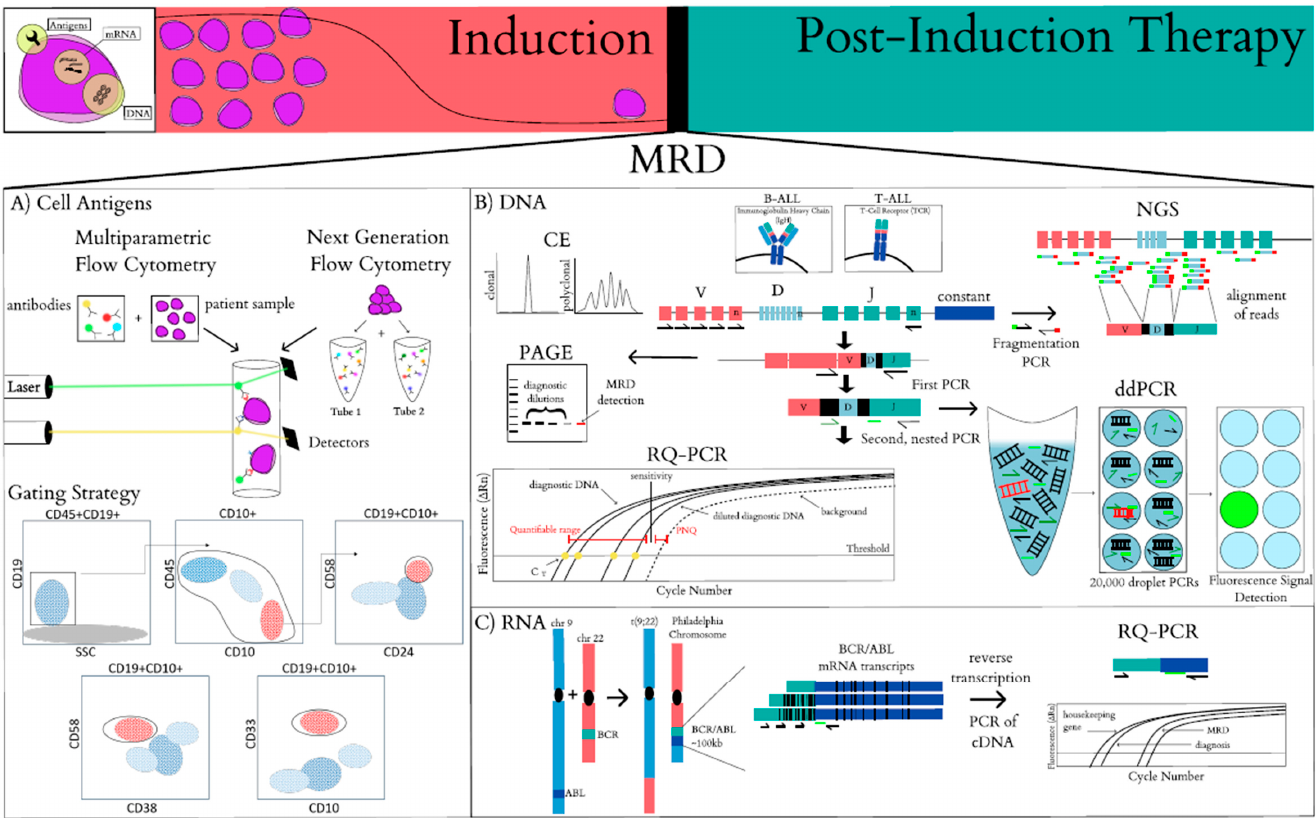
Figure 1. Methods of detection for MRD. ( A ): Representative schematic of multiparametric flow cytometry detection of the leukemia-associated immunophenotype. Antibodies conjugated to individual fluorochromes are incubated with the patient sample, either using 4–5 colors for traditional methods, or 8 colors (targeting 10 different antigens) in two separate tubes with next generation flow cytometry. Schematic example showing a gating strategy of a post induction sample analyzed with an informative antibody panel that allows the identification of residual leukemic blasts by deviation from normal lymphoid progenitors based on lineage and maturational stage. Examination of this CD45dimCD19+CD10+ population reveals blasts that are CD58+CD24+CD38dimCD33+. ( B ): MRD detection using DNA as a substrate for targeting the immunoglobulin heavy chain (IgH) for B-ALL or the T cell receptor (TCR) for T-ALL. Black boxes between V(D)J segments represent patient specific rearrangements formed during V(D)J recombination. Five representative schematics contrasting the assays utilizing this target, counterclockwise: capillary electrophoresis (CE), polyacrylamide gel electrophoresis (PAGE), real time quantitative polymerase chain reaction (RQ-PCR), digital droplet polymerase chain reaction (ddPCR) and next generation sequencing (NGS). ( C ): MRD detection using RNA as a substrate to track chromosomal translocations. An example is shown for the reciprocal translocation of t(9;22)(q34;q11) that results in the BCR/ABL